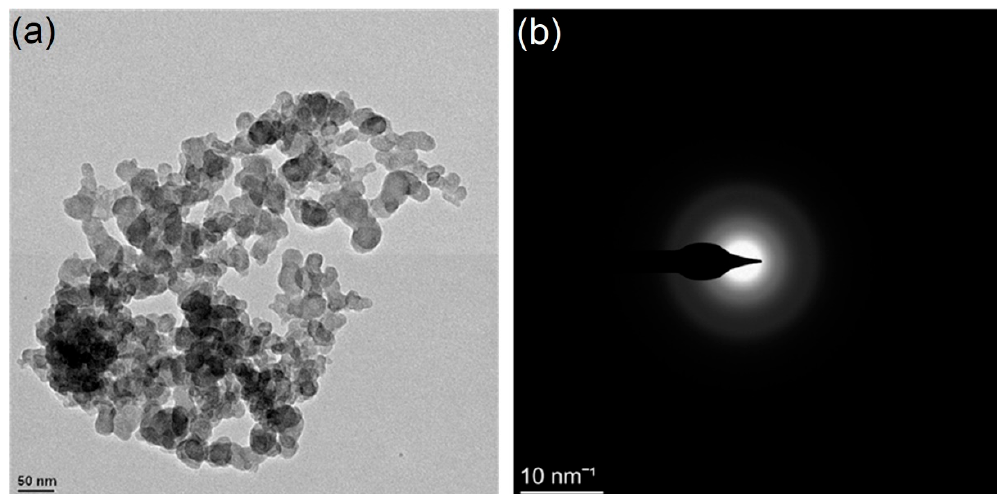
Figure 3. TEM microscopy of amorphous calcium silicate hydrate: ( a ) morphology of amorphous calcium silicate hydrate; ( b ) selected area electron diffraction (SAED) pattern.